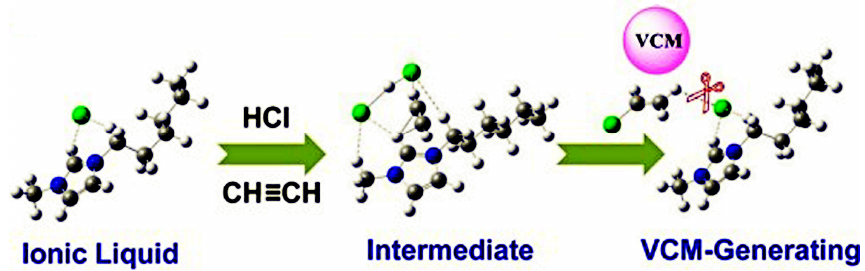
Figure 22. ILs catalyst for acetylene hydrochlorination [137].